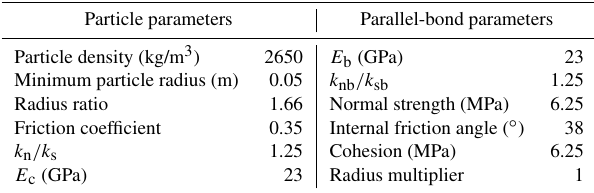
Table 2. Values of the BPM